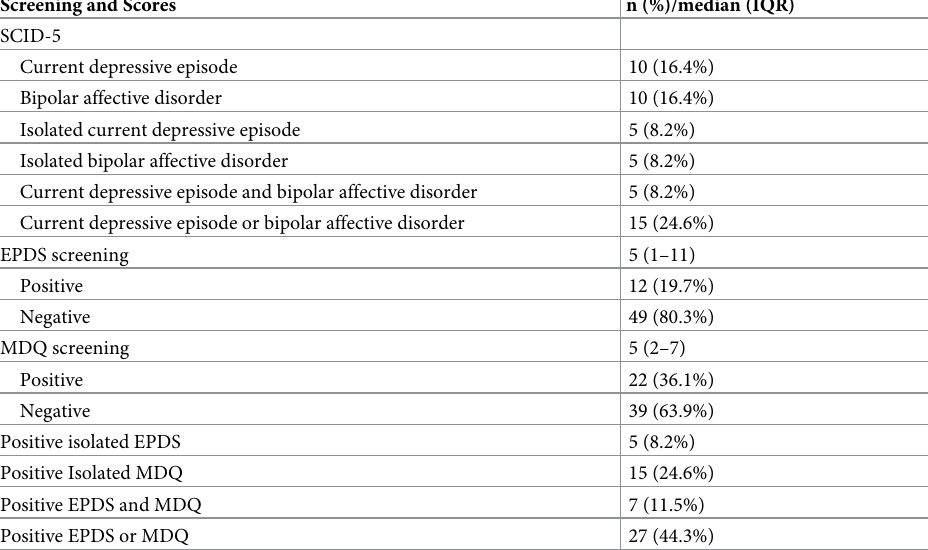
Table 2. Scores and results of the Edinburgh Postpartum Depression Scale, Mental Disorder Questionnaire and frequency of depressive disorder and bipolar